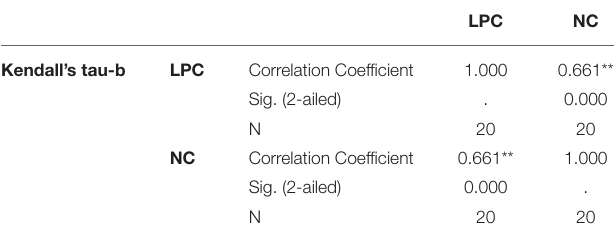
TABLE 4 | Correlation analysis of word length and frequency distribution between LPC and NC.